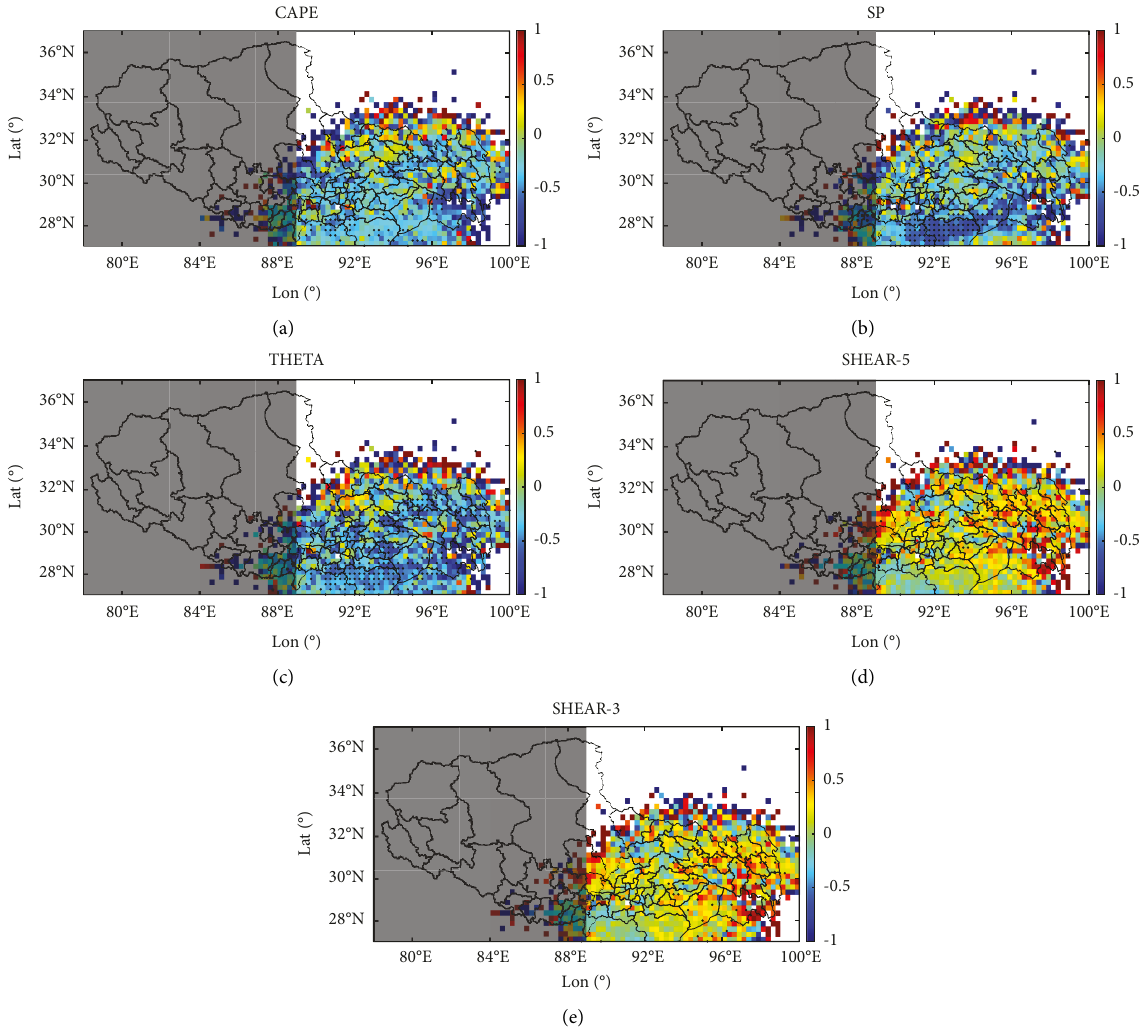
Figure 11: Correlation coefficients between the proportion of +CG (%) and (a) CAPE (J/kg), (b) SP (hPa), (c) THETA (K), (d) SHEAR-5 (m/s), and (e) SHEAR-3 (m/s) between May and October, the correlation coefficients in the figure are calculated based on the monthly average data of 60 months, and the black dots in the figure indicate that the point passed the 95% significance